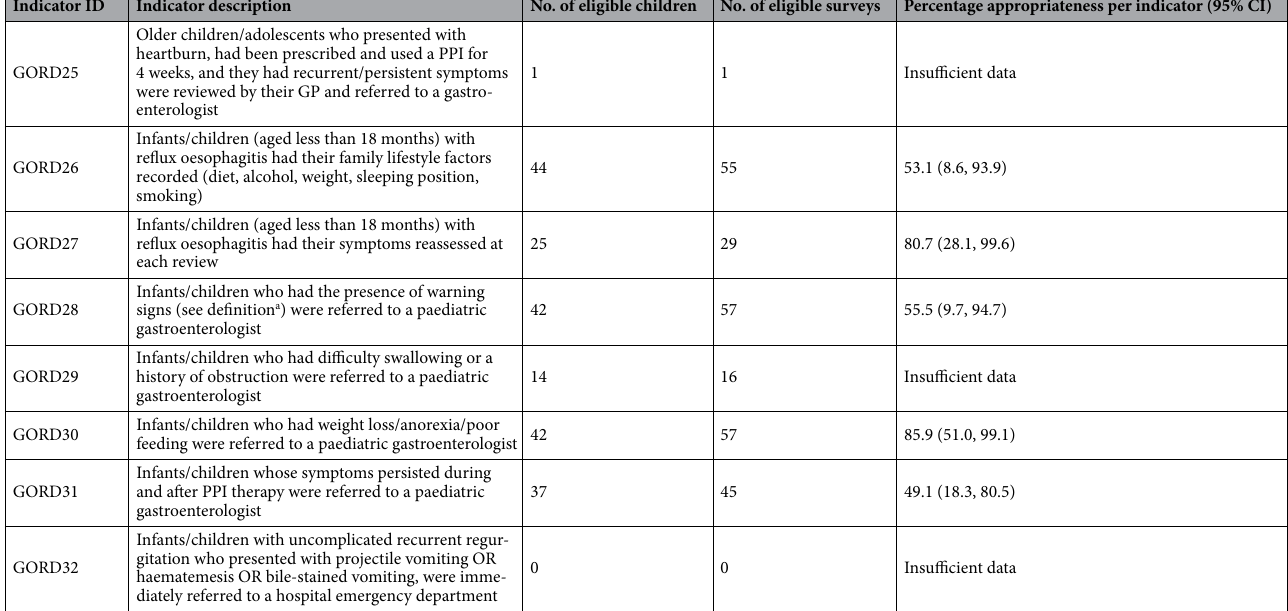
Table 2. Appropriateness of care, by clinical indicator. MC&S Microscopy, Culture and Sensitivities, PPI Proton-Pump Inhibitor. a Includes: Bilious vomiting; Gastrointestinal bleeding; Hematemesis; Hematochezia; Consistently forceful vomiting; Onset of vomiting after 6 months of life; Failure to thrive; Diarrhea; Constipation; Fever; Lethargy; Hepatosplenomegaly; Bulging fontanelle; Macro/microcephaly; Seizures; Abdominal tenderness or distension; Documented or suspected genetic/metabolic